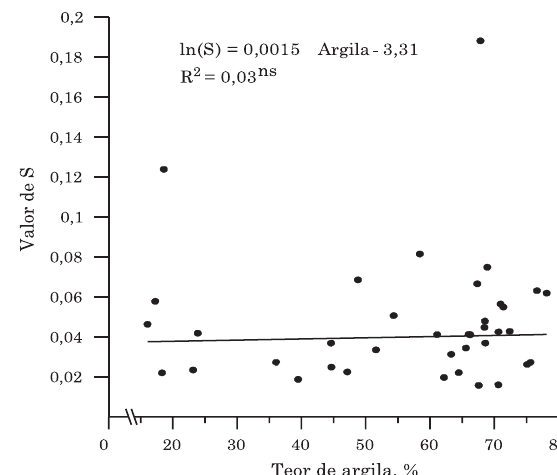
Figura 2. Comportamento do parâmetro S em função do teor de argila para diferentes solos do sul do Brasil (ns: o modelo ajustado não é significativo a p < 0,05 pelo teste F).